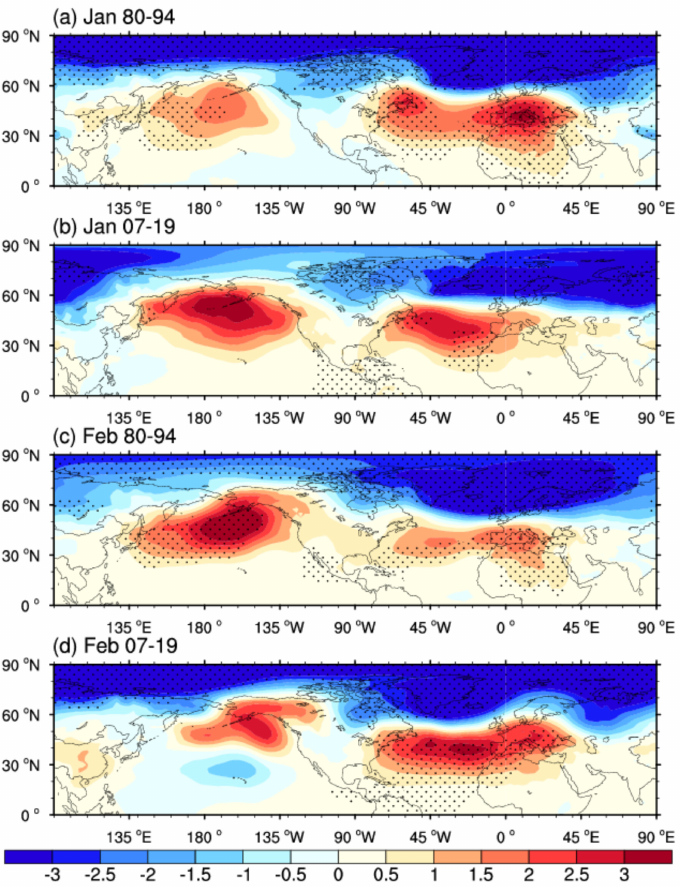
Figure 6. Regression maps of the SLP (shading; units: hPa) on AO index in ( a , b ) January, and ( c , d ) February during ( a , c ) 1980–1994 and ( b , d ) 2007–2019. The values over the stippled regions are statistically significant at the 95% confidence